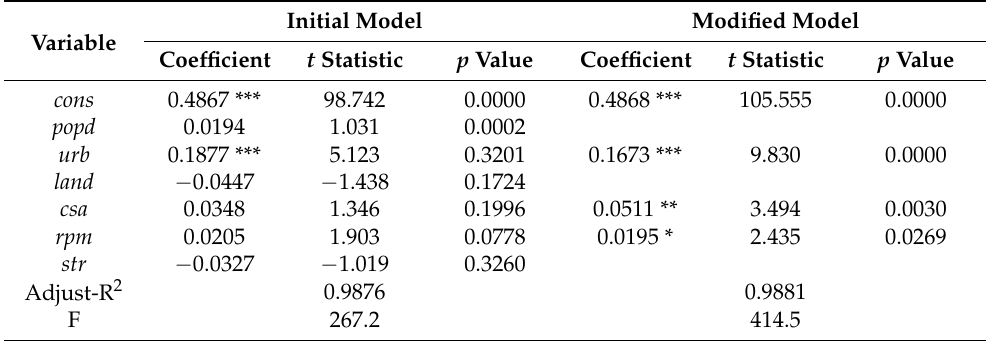
Table 5. Regression